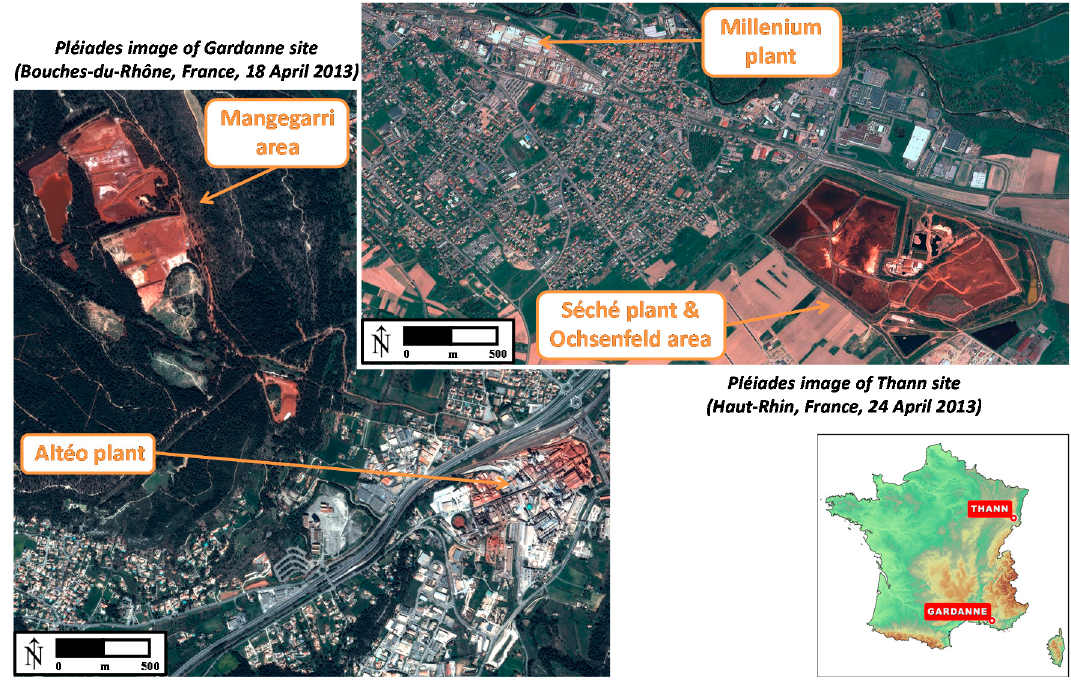
Figure 1. Localization and general view of Gardanne and Thann test sites.